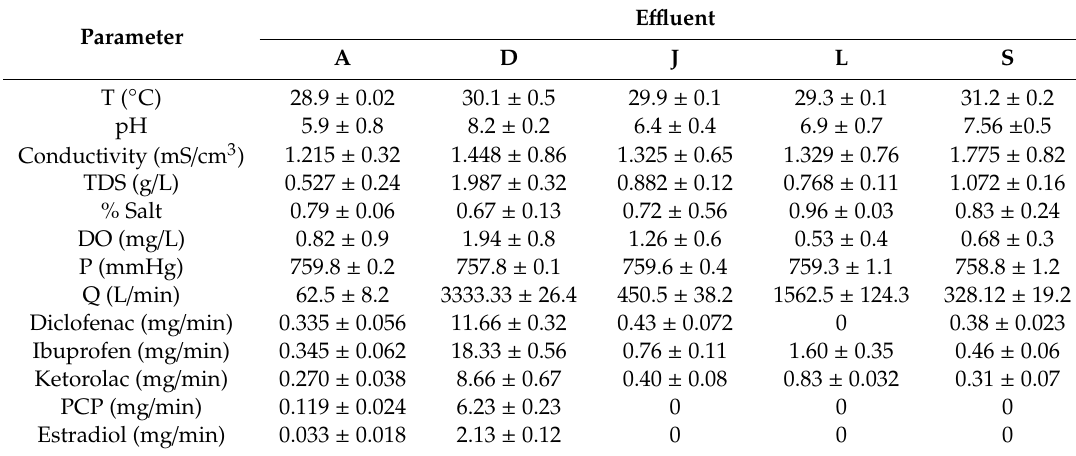
Table 3. Average characterization values of the e ffl uents.